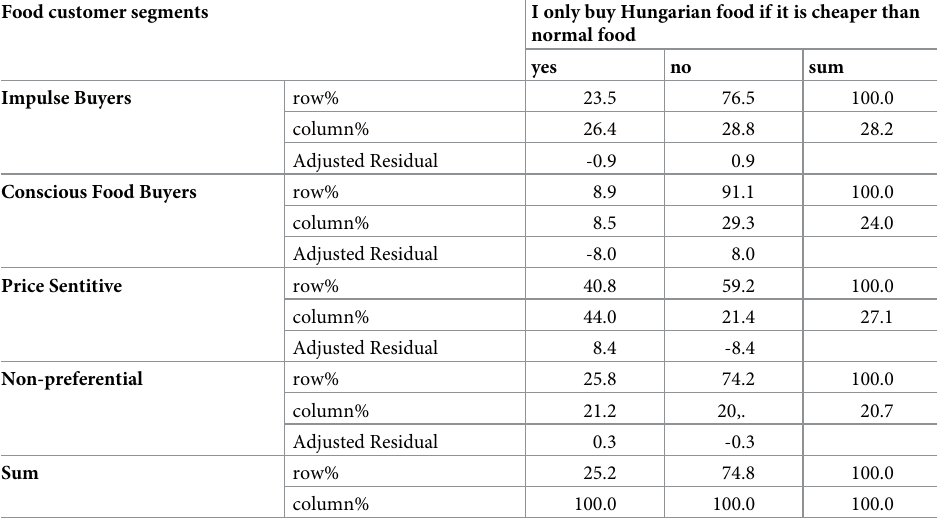
Table 8. Opinions of food shopping segments on the purchase of cheaper Hungarian food. Food customer